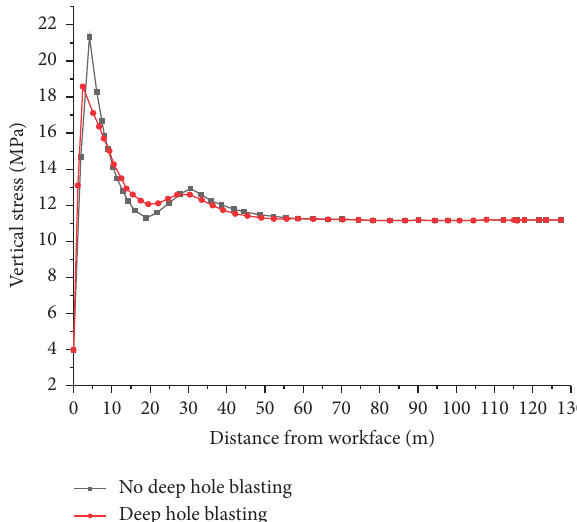
Figure 11: Vertical stress curves under deep hole blasting.